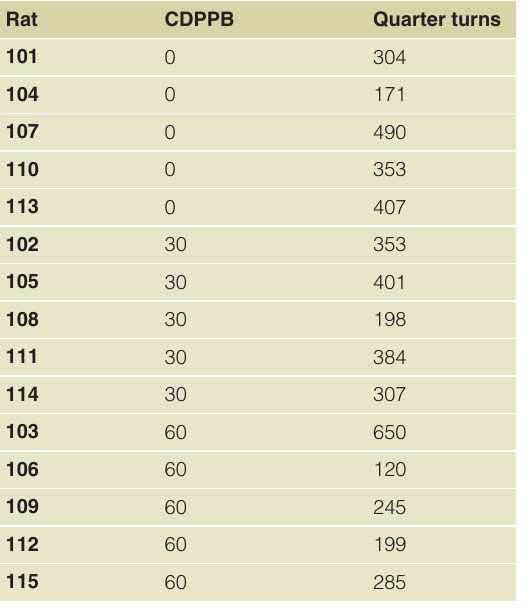
Table S10. Locomotor response (total quarter turns over 90 min) to Fenobam (0, 10, 30